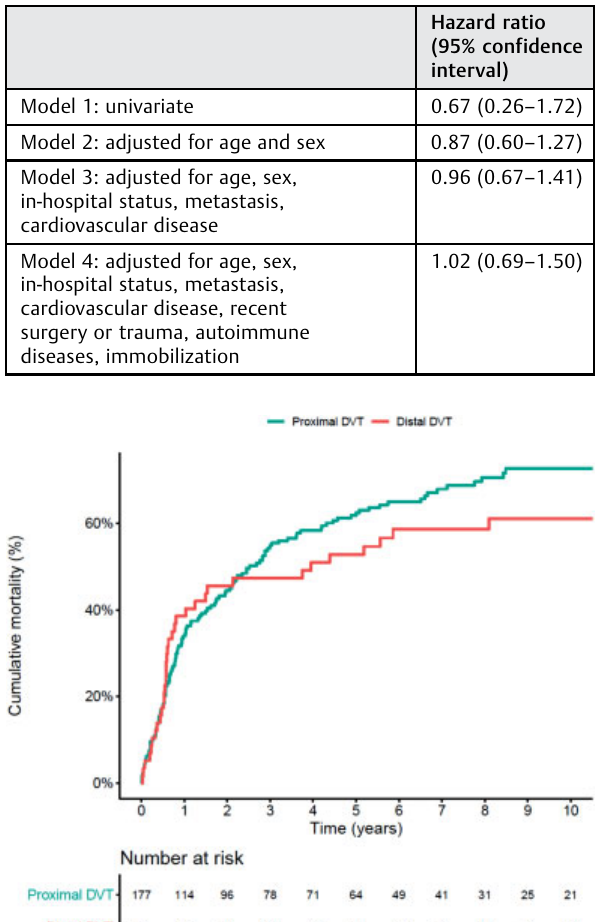
Fig. 2 Cumulative rate of recurrent deep vein thrombosis (DVT) or pulmonary embolism in patients with fi rst distal versus proximal DVT strati fi ed according to baseline risk factors. Table 3 Impact of distal (vs. proximal) deep vein thrombosis location on mortality in cancer patients